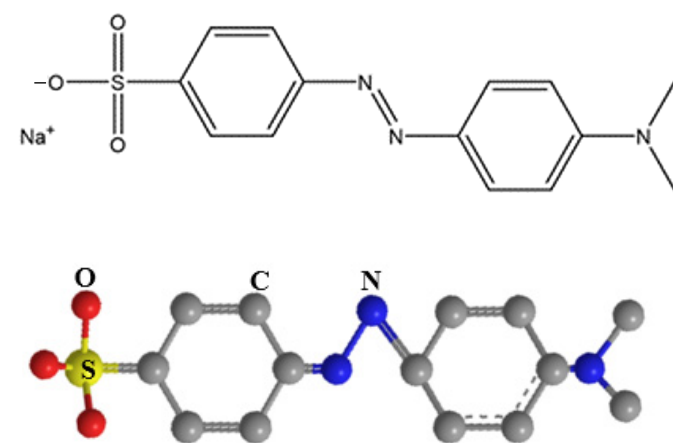
Figure 17. Molecular structure formula of methyl orange.